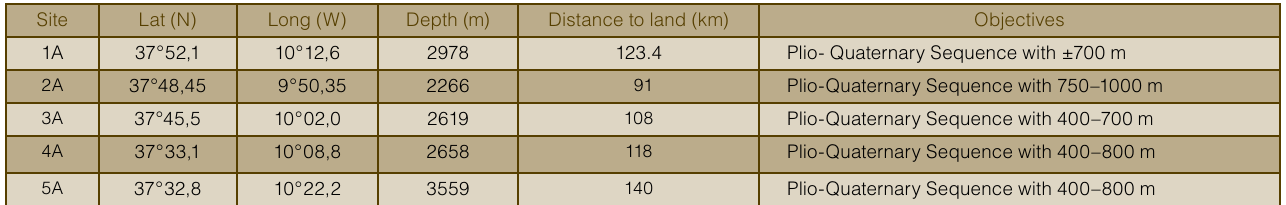
Table 1. Location of proposed drilling site